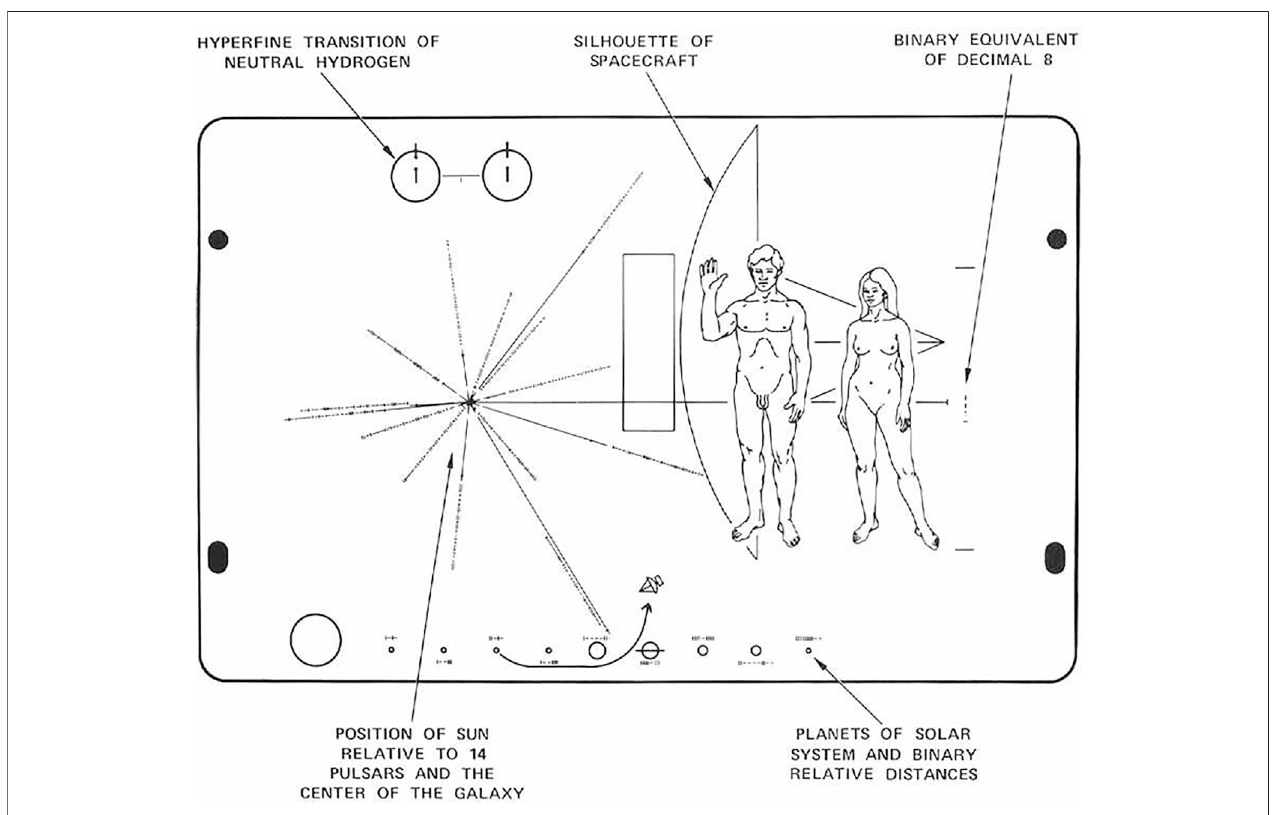
FIGURE 2 | Line drawing of the Pioneer plaque with explanatory callouts. Credit: NASA History.